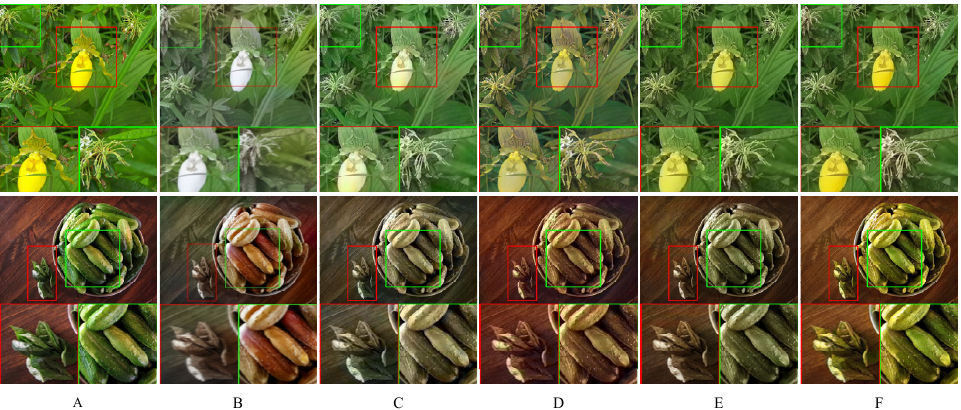
Figure 8. The results of the ablation experiment 1. ( A ) Real image; ( B ) U ‐ Net; ( C ) U ‐ Net + G1; ( D ) U ‐ Net + G3; ( E ) G1 + G3; ( F ) Proposed method. The red and green rectangular box represent the area where the colorization effect of each method differs greatly and enlarged images of the area.